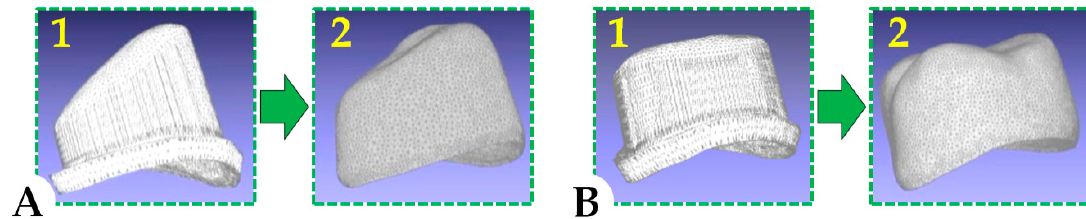
Figure 1. Three-dimensional frames representing the computerized design for the primary (1) and the secondary (2) telescopic crowns dedicated to an upper canine ( A ) and an upper molar ( B